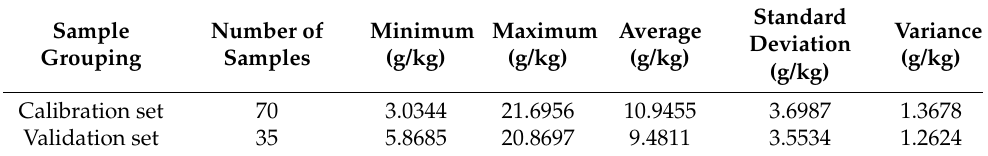
Table 3. Statistics of the SOM content.